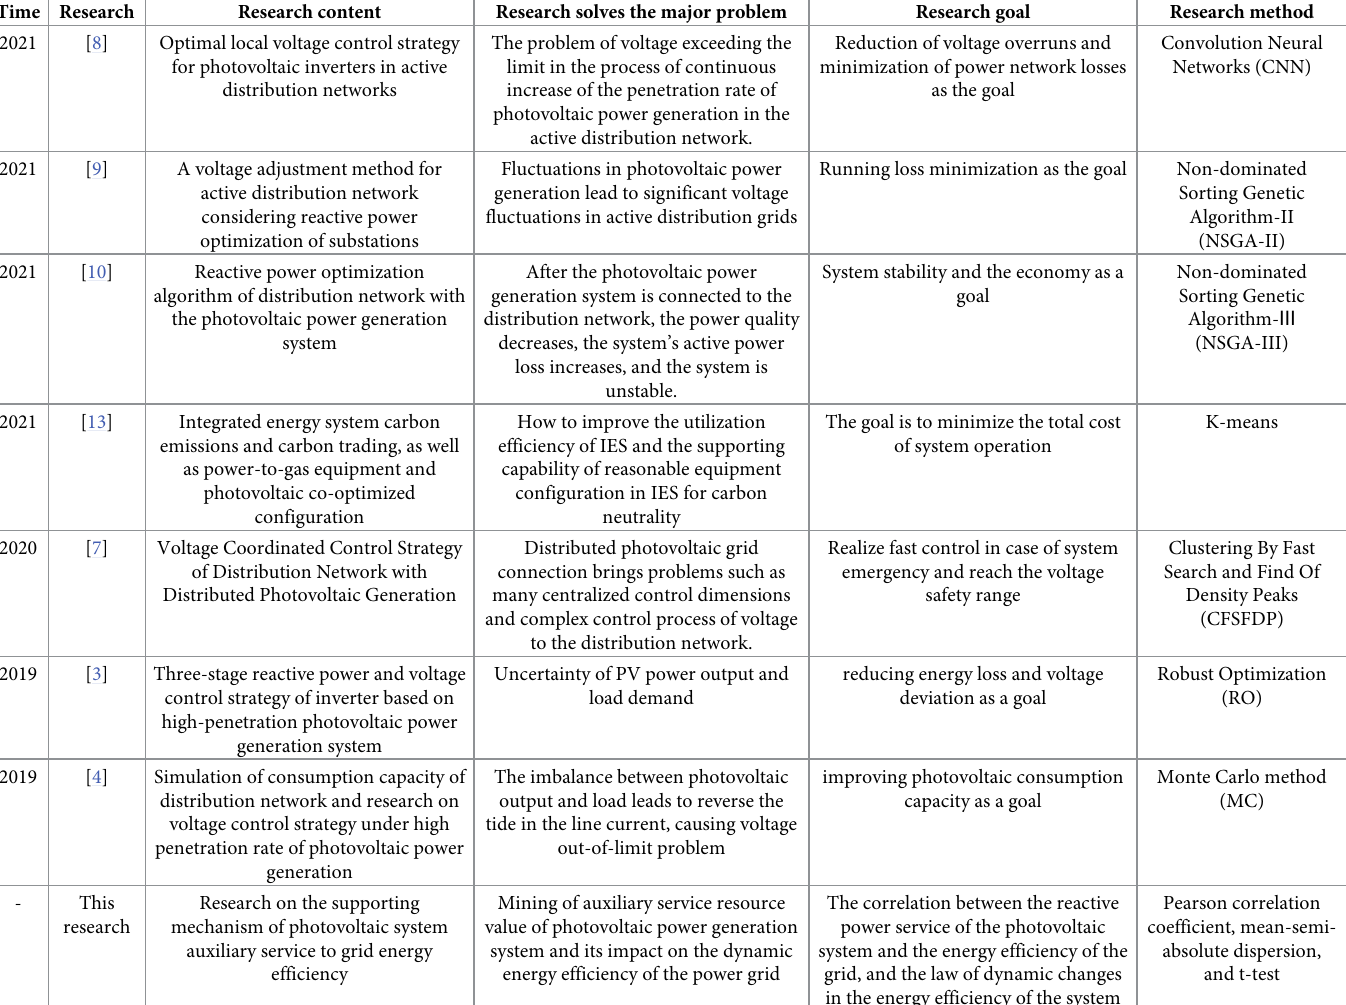
Table 1. Comparison table of differences between the research in this article and the main related literature research. Time Research Optimal local voltage control strategy The problem of voltage exceeding the for photovoltaic inverters in active limit in the process of continuous increase of the penetration rate of photovoltaic power generation in the active distribution network. A voltage adjustment method for active distribution network considering reactive power optimization of substations Reactive power optimization algorithm of distribution network with the photovoltaic power generation system